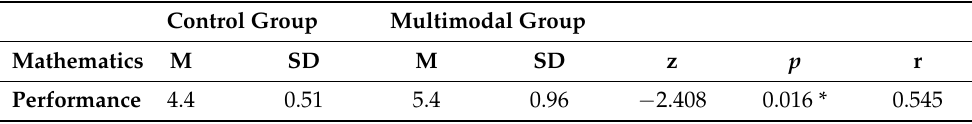
Table 14. Comparison between control and multimodal groups in the post-test. Mathematics